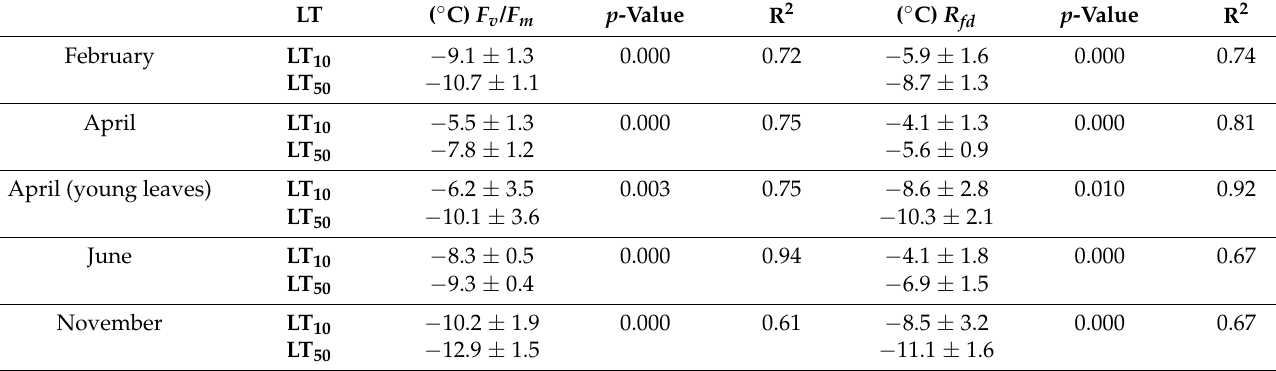
Table 1. LT 10 and LT 50 estimated from low temperature treatments from the maximal photochemical efficiency of PSII ( F v /F m ) and the R fd data shown in Figure 1 and obtained from the regression model. Values are mean ± confidence interval. Significance ( p -value) and fit (R 2 ) to the regression are